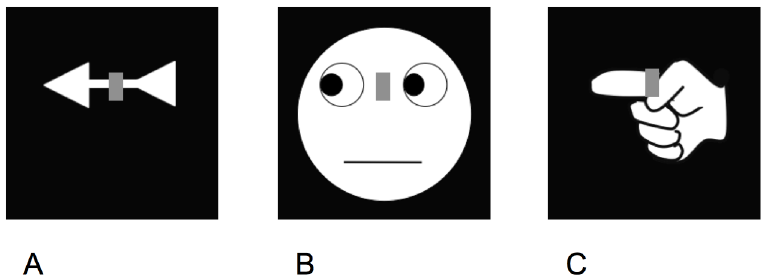
Fig 1. Examples of stimuli presented to induce the Simon effect. The examples shown here cue a left location (other stimuli cued a right location). Locations were cued by the arrow (A), the eye gaze (B), or the pointing hand (C). The superimposed rectangle (target) was shown either in red or green and responses varied as a function of target colors. It should be noted that the left location was cued by the left hand; direction and effector were always spatially